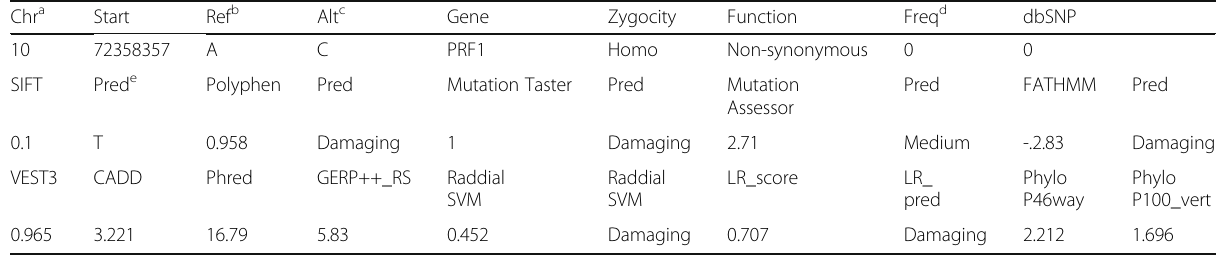
Table 2 Bioinformatic analysis of new identified mutation (p.W374G) in PRF1 gene in the proband Chr a